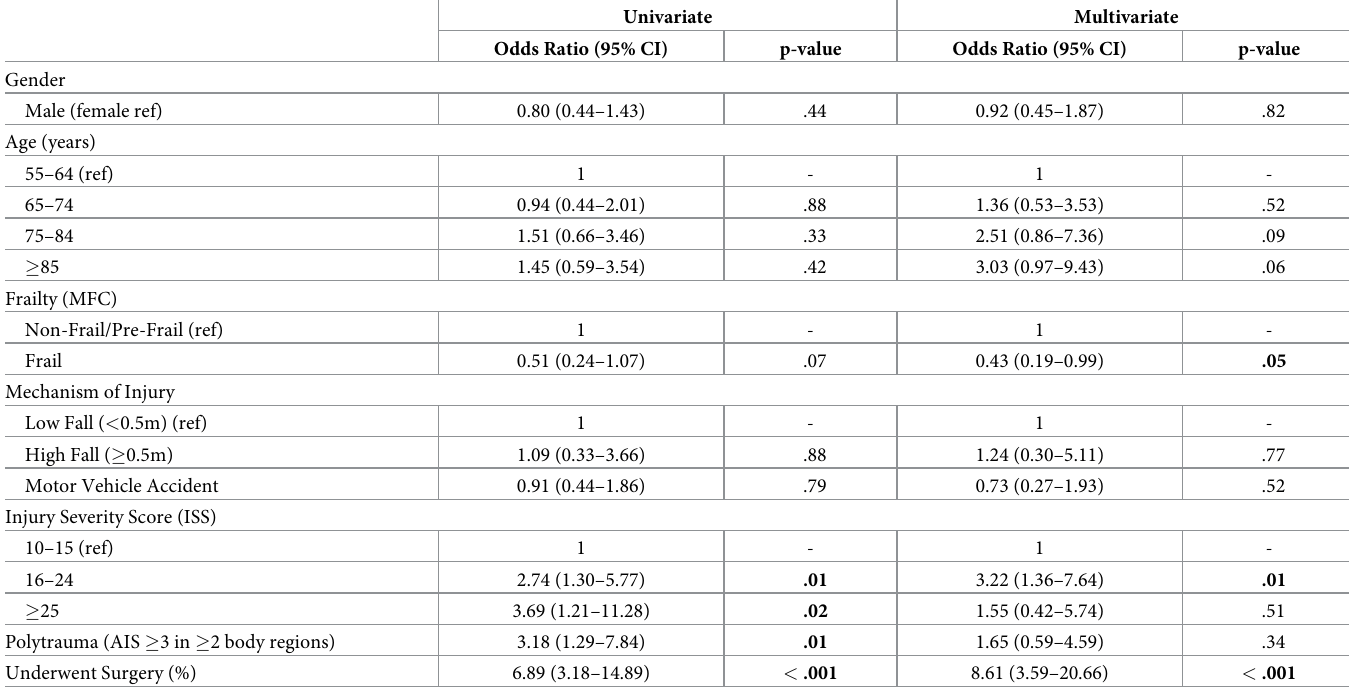
Table 2. Multivariable regression for length of stay.